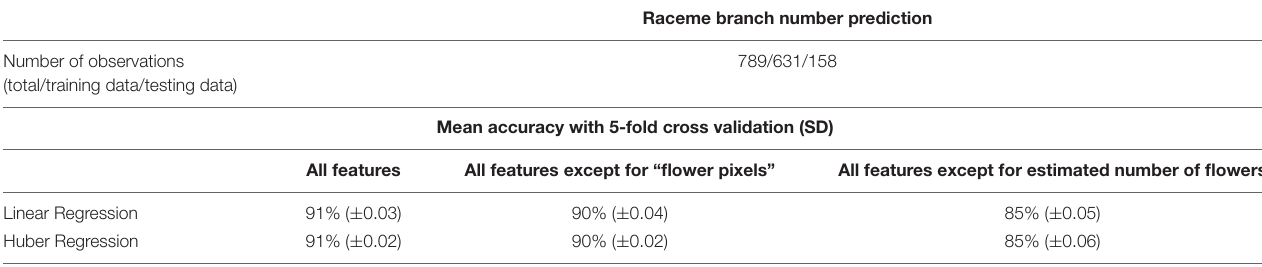
TABLE 1 | Mean accuracies for inflorescence branch number prediction from image-derived traits for 50 B. napus genotypes using different machine learning